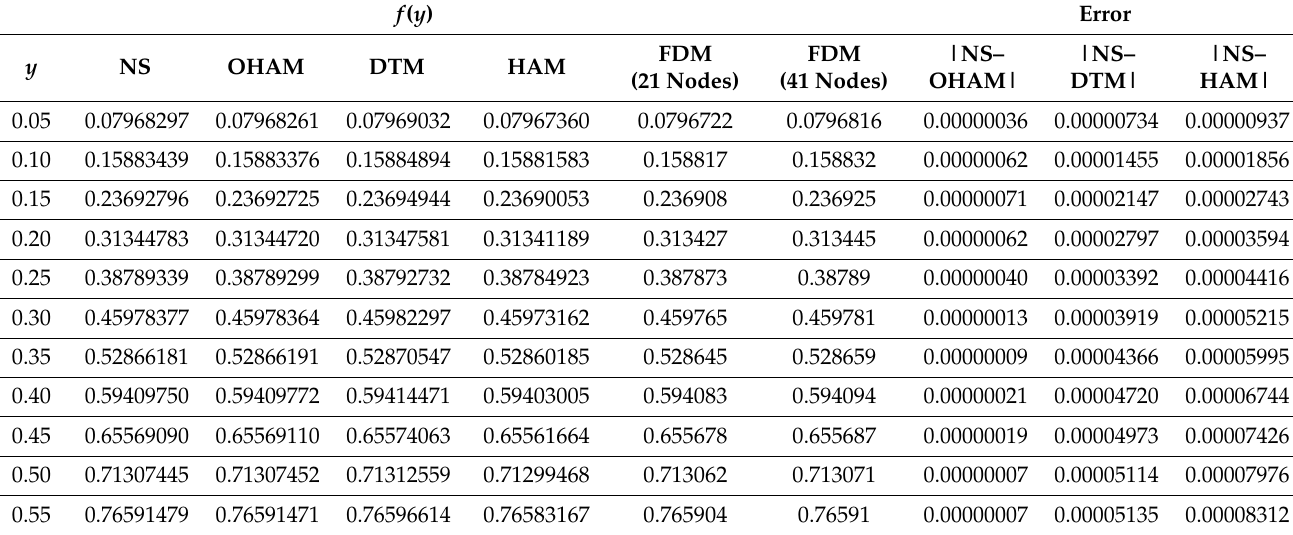
Table 3. Comparison of the numerical solution (NS) with the OHAM and HAM by 5th-order approximate solution and DTM ( m = 30) for the case of Re = 5 and α =